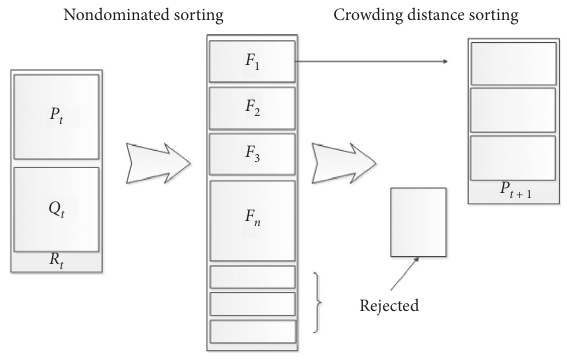
Figure 1: Structure of